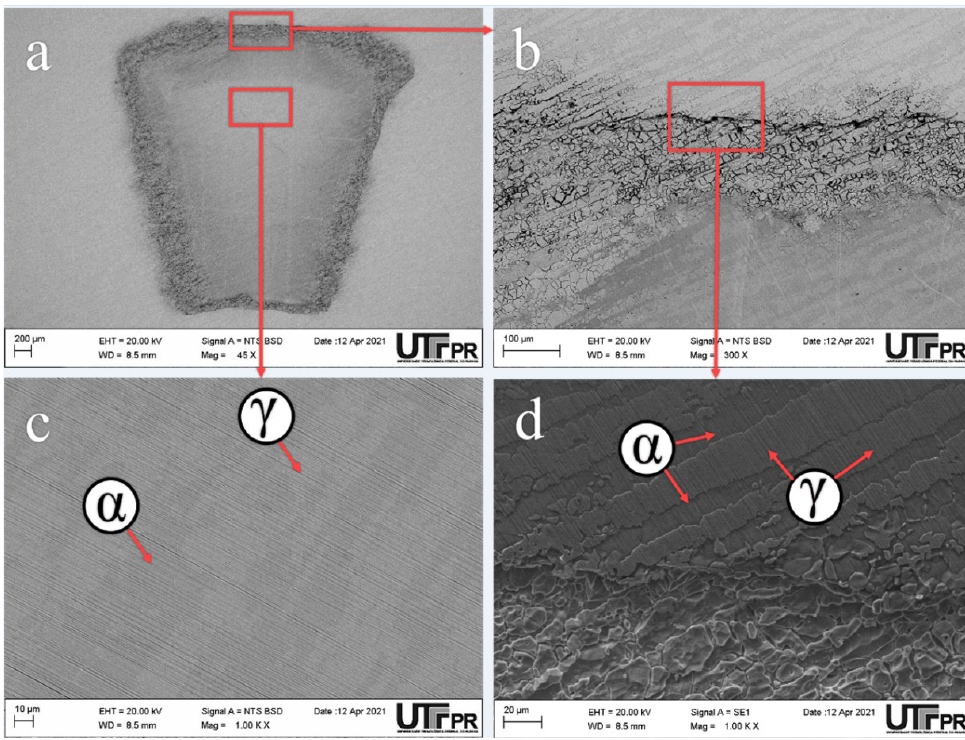
Figure 11. a. SEM micrographs of the crevice attacked site (* in Figure 10a) generated in a BM sample in PD-PS-PD tests in NaCl 3.5% wt. solution. b-d. Magnifications.